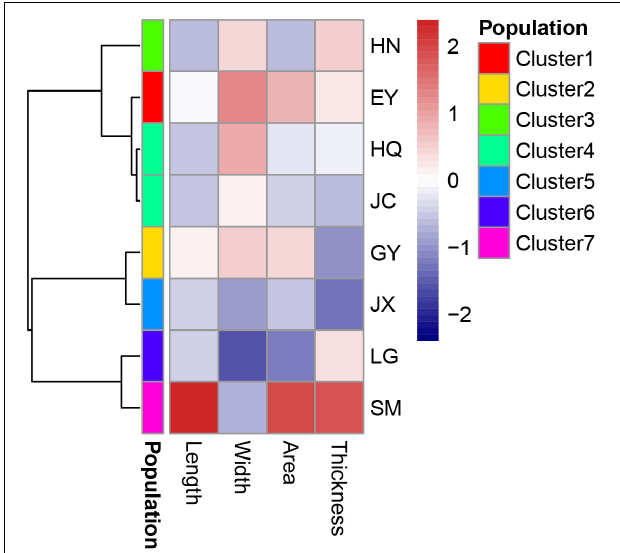
FIGURE 7 | The cluster analysis of leaf traits of morphology and biomass in the eight populations. Leaf length and width is with the unit of cm, area with the unit of cm 2 and thickness with the unit of